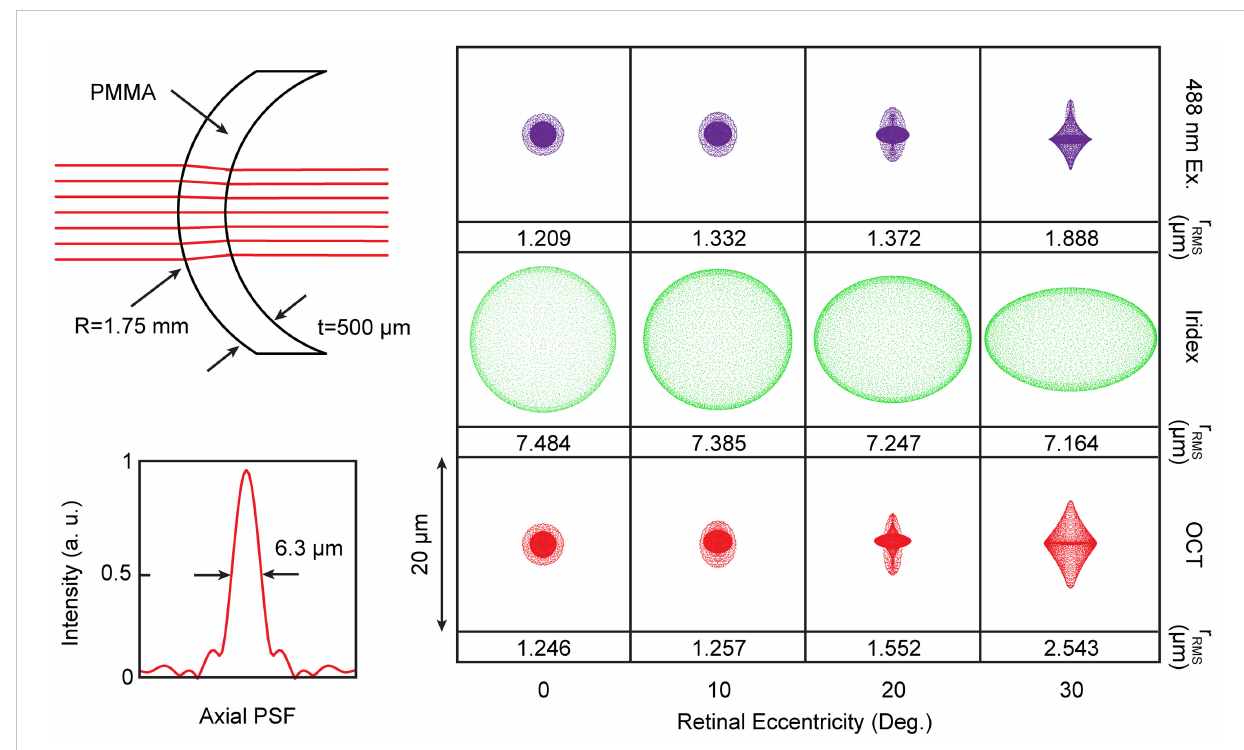
FIGURE 2 Optical schematic of contact lens and corresponding optimize spot sizes for SLO excitation, lesioning laser, and OCT. Spot sizes are shown up to 30 deg. retinal eccentricity, which corresponds to maximum FOV in the murine eye. Corresponding lateral spot sizes are shown as root-mean-square radii and inset shows OCT axial point-spread-function. Black arrows point to corresponding dimensions (i.e., R - radius of curvature, t - thickness, PMMA - lens material, full width half maximum of axial PSF).